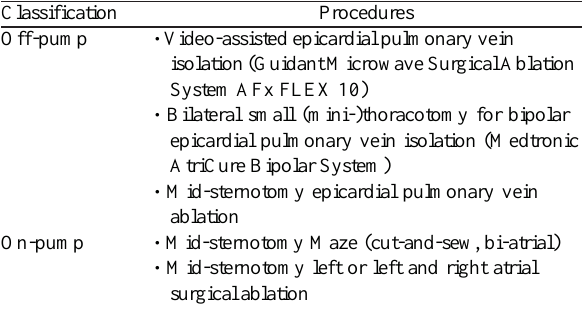
Table 2. Classification of Maze procedures.